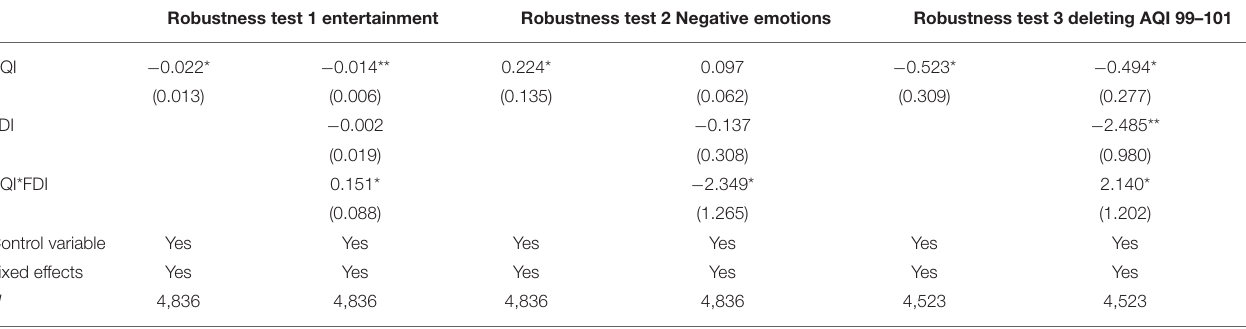
TABLE 5 | Robustness test.